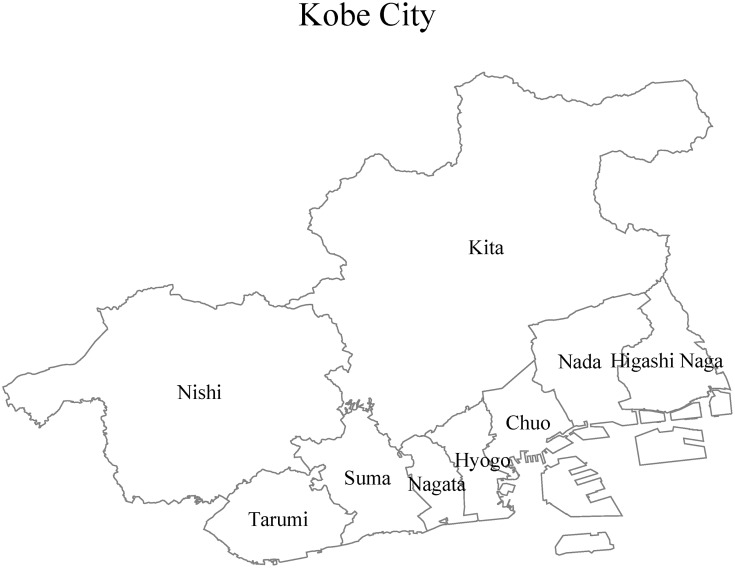
Wards in Kobe City.